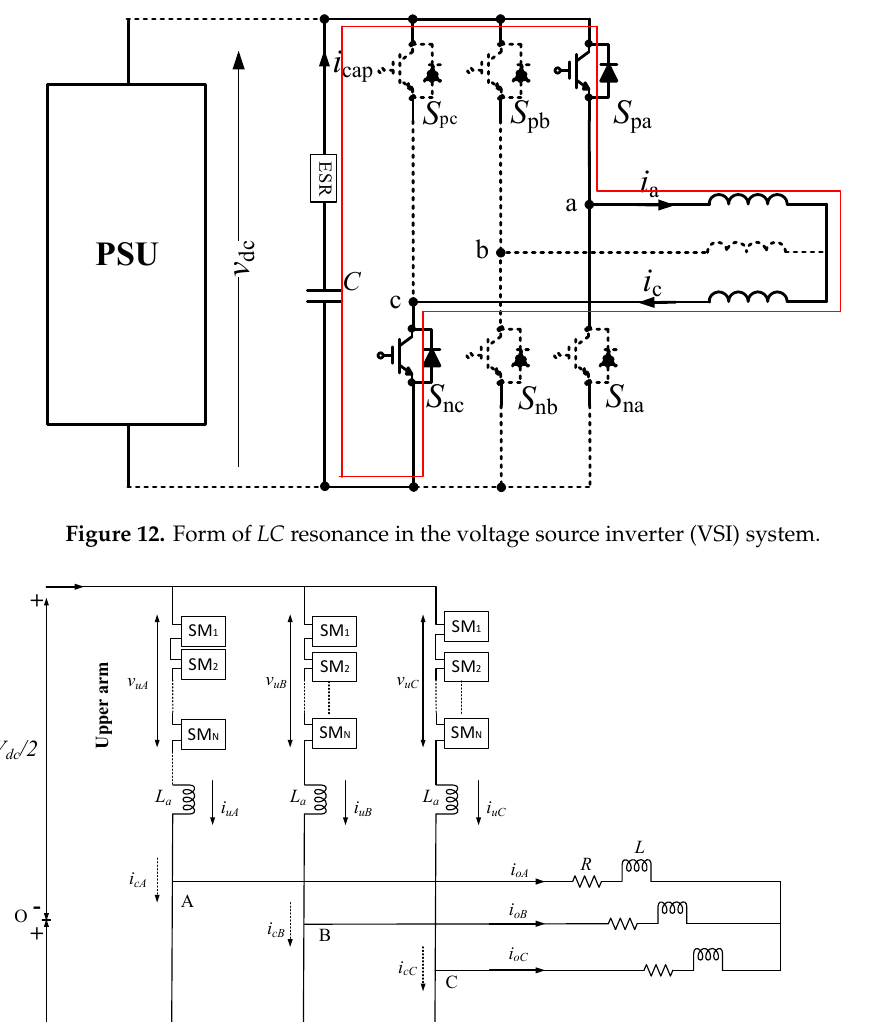
Figure 12. Form of LC resonance in the voltage source inverter (VSI) system.